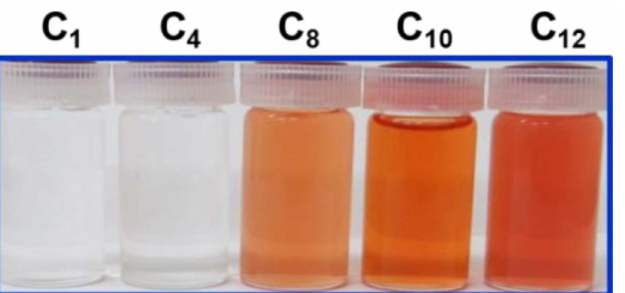
Figure 4. Differences in solution appearance depend on the carbon chain length of the polymer when dissolving Sudan III.